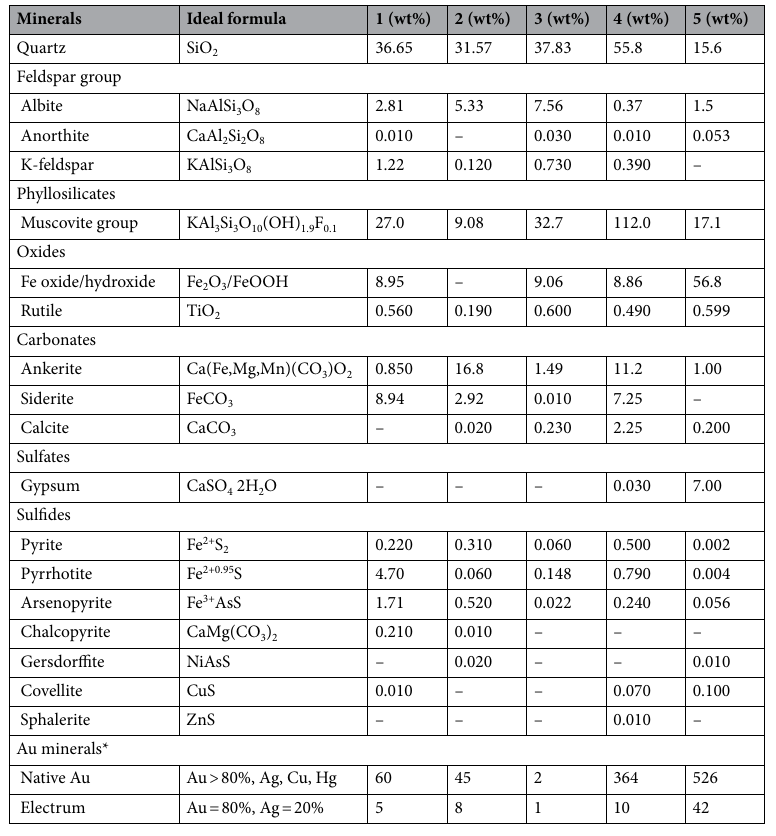
Table 2. Means values of the modal mineralogy of the deposits 1 (**N = 130), 2 (N = 207), 3 (N = 400), 4 (N = 229) and 5 (N = 193). *Au particles accounting; ** N number of